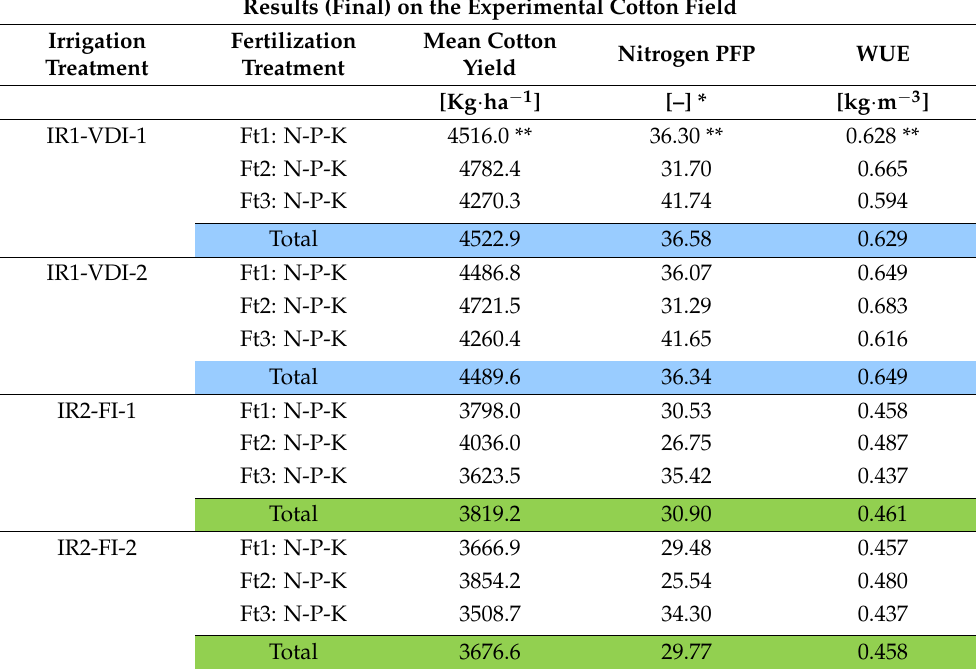
Table 6. Results on the cotton yield, nitrogen partial factor productivity (PFP), and water use